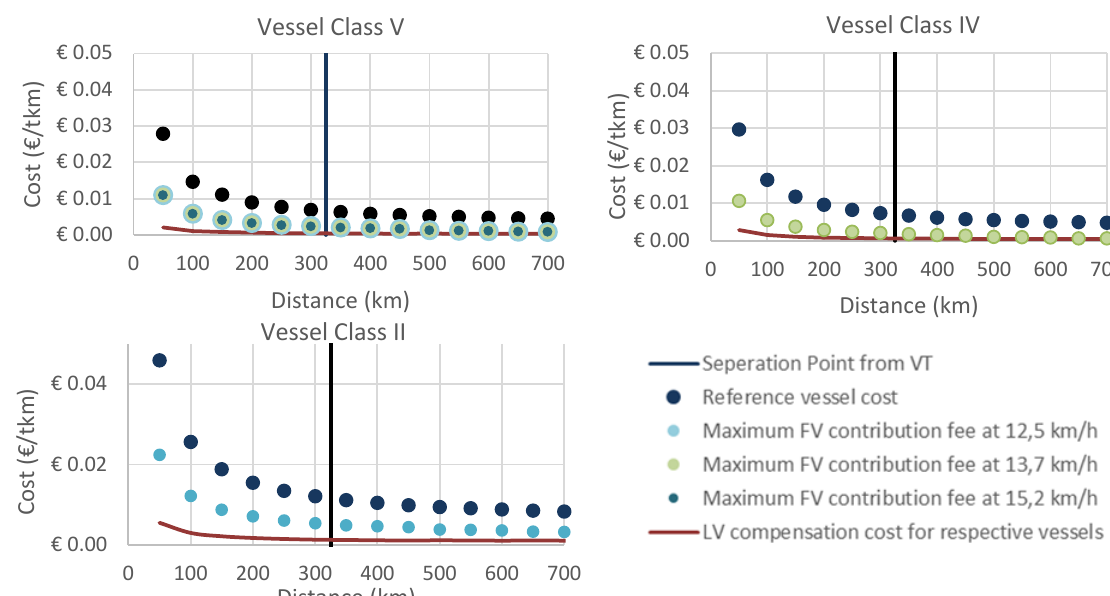
Figure 8: Cost per ton-km Comparison to Reference Vessels and the LV Compensation Cost for a B Operating